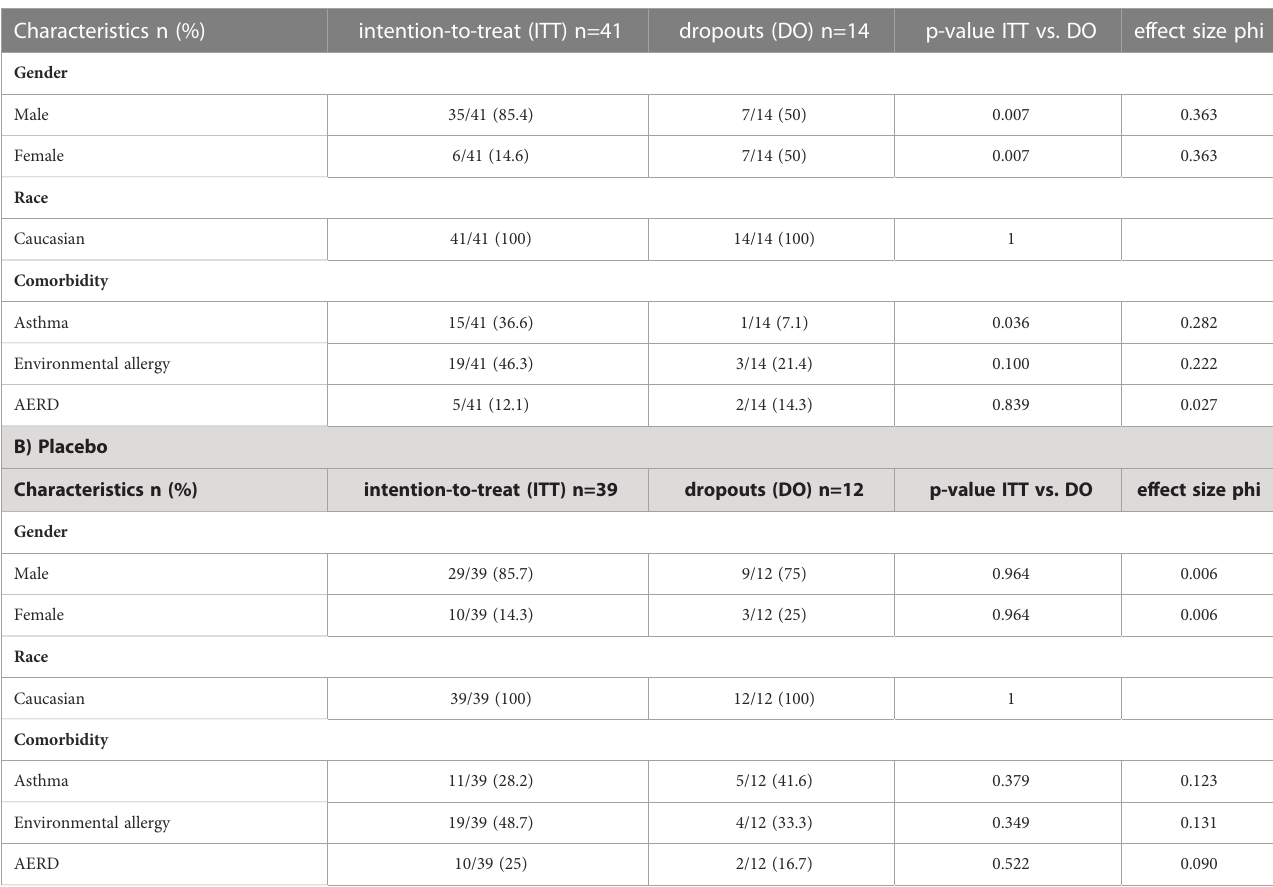
TABLE 3 Table comparing the baseline demographics and baseline characteristics for the intention-to-treat (n=80) and the dropout (n=26) groups (A) demographics for the steroid group (B) demographics for the placebo group (C) further characteristics for the steroid group (D) further characteristics for the placebo